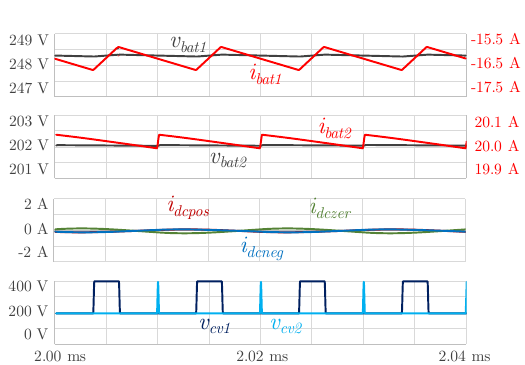
Figure 7. Simulation results of the V2V operation mode when EV1 is discharging with a current of 16.3 A and EV2 is charging with a current of 20 A.